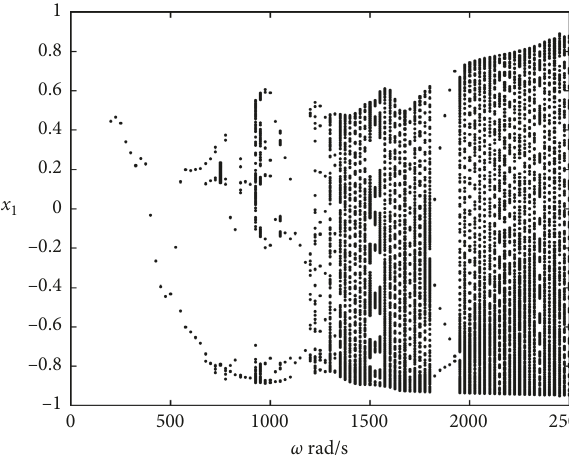
Figure 11: Bifurcation diagram of the rotor system in the x